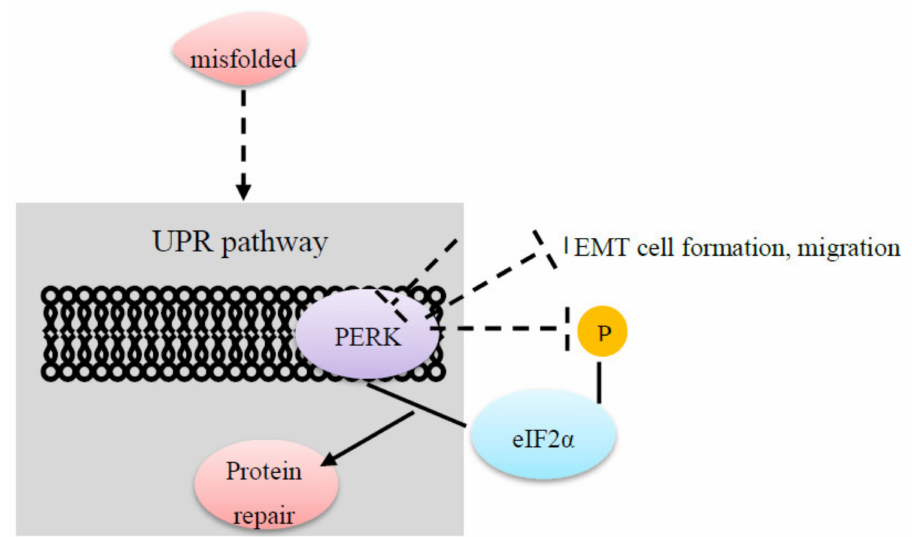
Figure 2. Misfolded proteins can activate the unfolded protein response (UPR) pathway. PERK which is located in the endoplasmatic reticulum membrane interacts with eIF2alpha to induce an integrated stress response to repair misfolded proteins. An inhibition of PERK impacts the phosphorylation of eIF2alpha and leads to a decrease in the EMT cell formation and migration